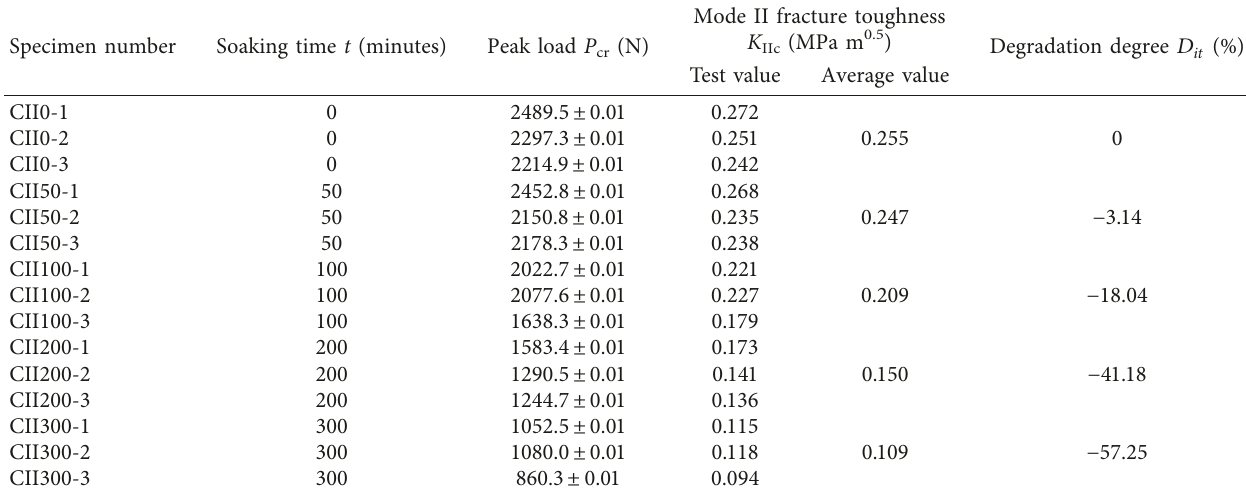
Table 7: Mode II fracture toughness of Type C mudstone specimens for different soaking